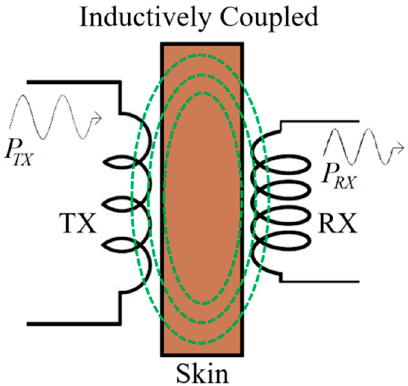
Figure 4. NRIC WPT system powered by alternative electromotive force (EMF). TX: transmitter coil RX; receiving coil.